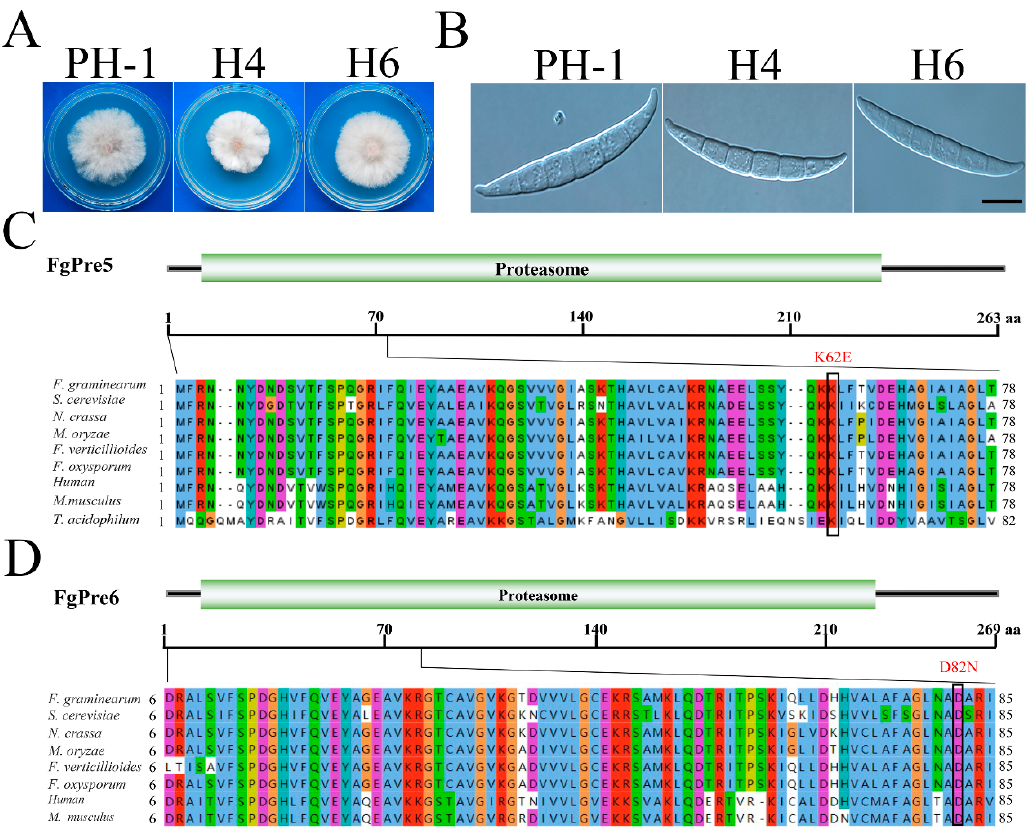
Figure 4. Suppressors of pkr with mutations in FgPRE6 and FgPRE5 . ( A ) Three-day-old PDA cultures of the pkr mutant and marked suppressors with mutations in FgPre5 and FgPre6. ( B ) Conidia of the same set of strains from 5-day-old CMC cultures. Bar = 10 µm. ( C ) Schematic drawing of the FgPre5 protein and alignment of its N-terminal 78-aa with orthologs from Fusarium graminearum (Fg), Saccharomyces cerevisiae (Sc), Magnaporthe oryzae (Mo), Neurospora crassa (Nc), F. oxysporum (Fo), Homo sapiens (Hs), Mus musculus (Mm), and Thermoplasma acidophilum (Ta). ( D ) Schematic drawing of the FgPre6 protein and alignment of its N-terminal 85-aa with orthologs from Fusarium graminearum (Fg), Saccharomyces cerevisiae (Sc), Magnaporthe oryzae (Mo), Neurospora crassa (Nc), F. oxysporum (Fo), Homo sapiens (Hs), and Mus musculus (Mm).